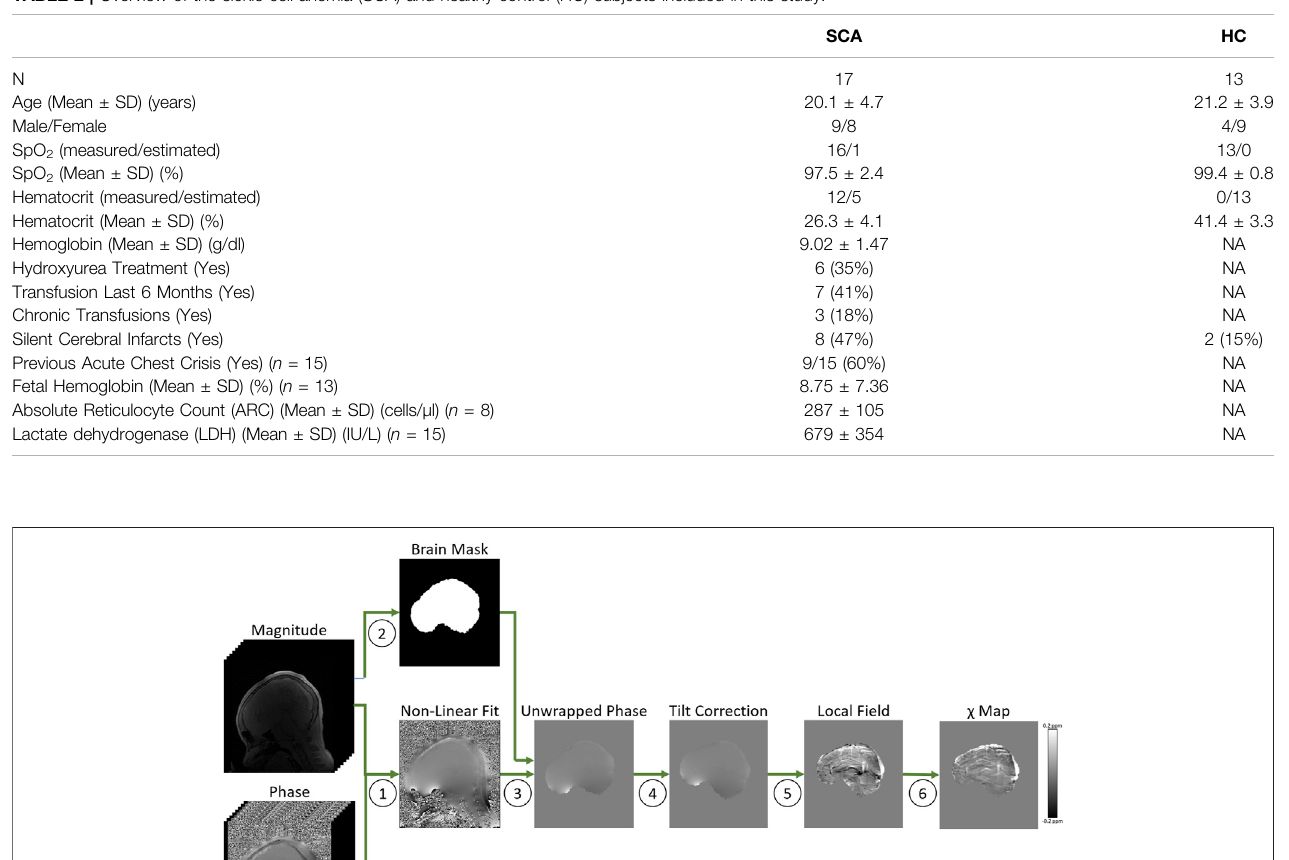
TABLE 2 | Overview of the sickle cell anemia (SCA) and healthy control (HC) subjects included in this study.